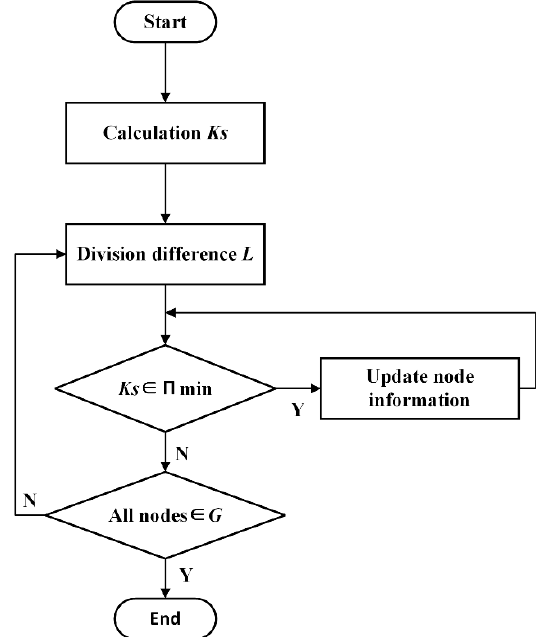
Figure 2. Flow chart of the improved K_shell algorithm.